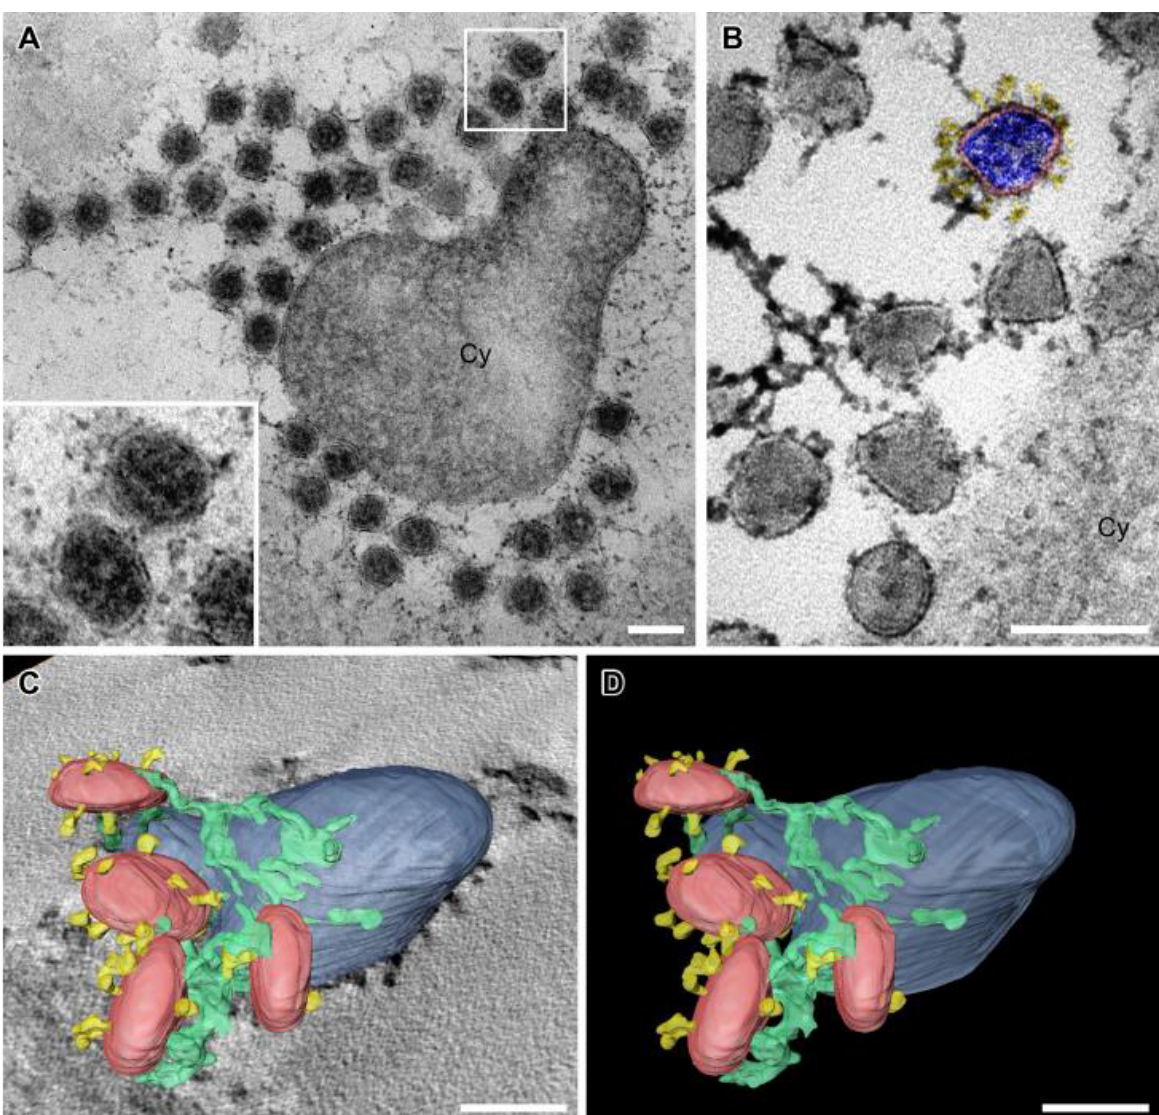
Figure 6. Accumulation of extracellular SARS-CoV-2 virions with prominent filamentous material between individual virions and between virions and the cell (Cy). ( A ) Virions (higher magnification in the insert) around a cross-sectioned cellular protrusion. ( B ) Virions at the cell surface. One virion is colored. Red: viral envelope; blue: nucleocapsid; yellow: S protein. ( C , D ) 3D segmentation of STEM tomography data showing tethered virions (red) with S proteins (yellow) connected by filamentous material (green) at the plasma membrane (blue). Full dataset shown in Supplementary Video S1. Scale bars, 100